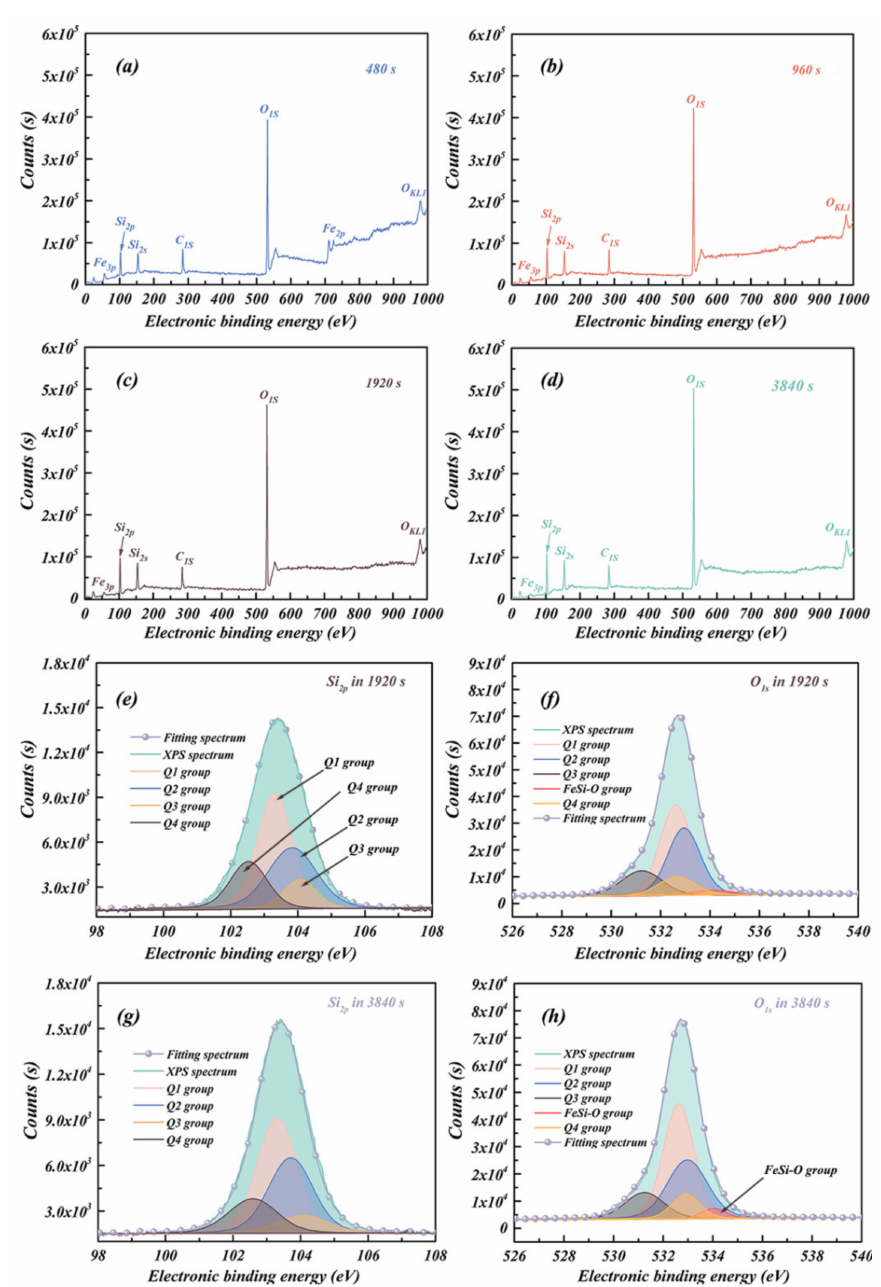
Figure 4. X-ray photoelectron spectroscopy (XPS) survey spectra of Fe-6.5wt.%Si / SiO 2 composite particles after deposition for ( a ) 480 s, ( b ) 960 s, ( c ) 1920 s, and ( d ) 3840 s. The deconvoluted Si 2p and O 1s spectra for electrons on the surfaces of Fe-6.5wt.%Si / SiO 2 C-S particles after deposition for 1920 s ( e ,f) and 3840 s ( g